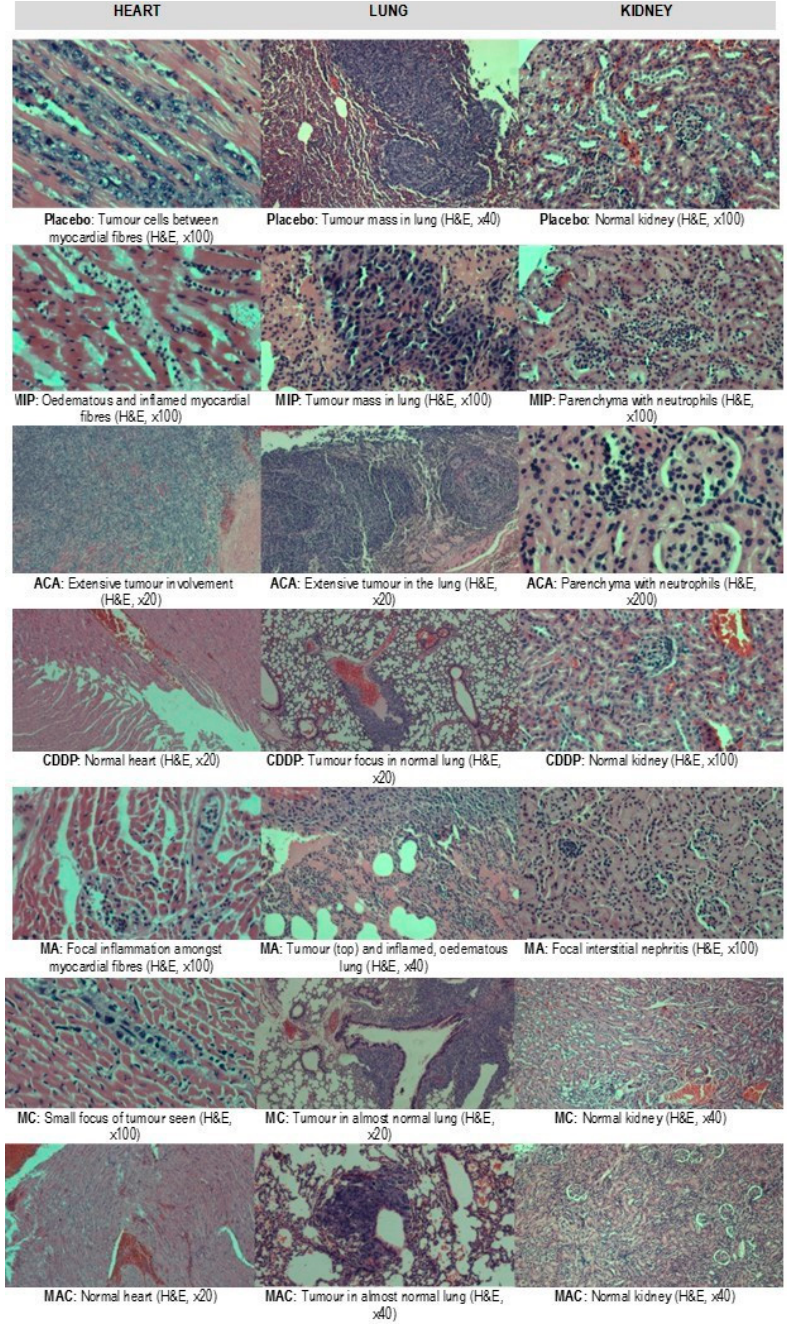
Figure 2. Preliminary toxicity evaluations in the hearts, lungs, and kidneys of BALB/c mice with breast cancer after treatment with placebo, Mycobacterium indicus pranii (MIP), 1 ′ -S-1 ′ -acetoxychavicol acetate (ACA), cisplatin (CDDP), ACA/MIP (MA), CDDP/MIP (MC), and ACA/MIP/CDDP (MAC). Hematoxylin and eosin stain. × original magnification.